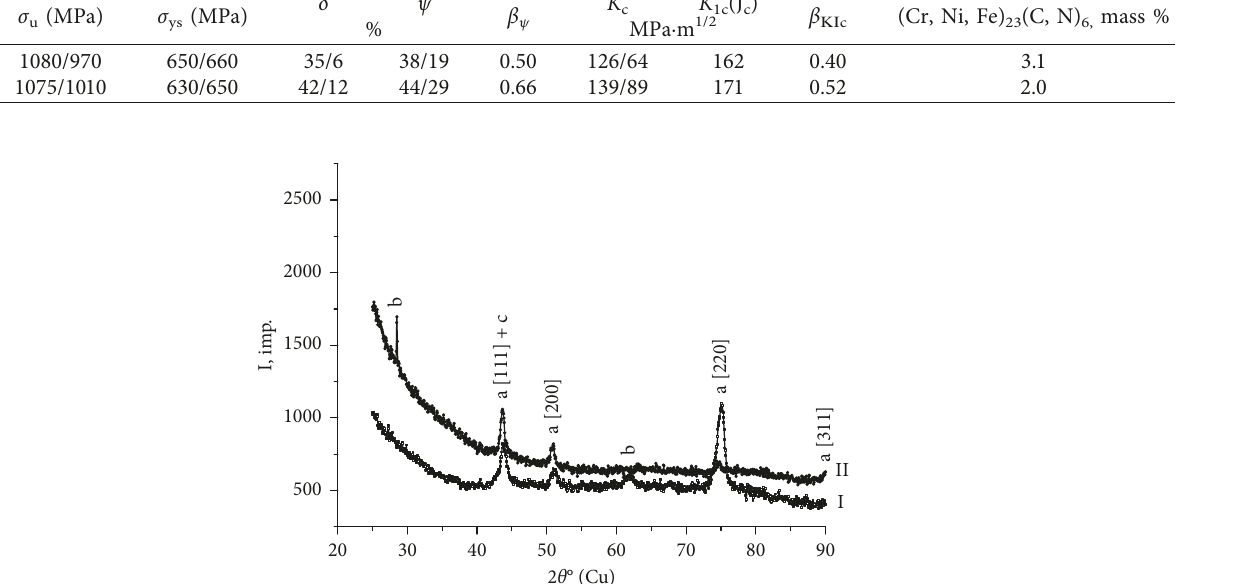
Figure 7: X-ray patterns of the alloys with different content of carbides (I, II, see Table 1): a, Ni-base solid solution; b, Ni c, (Cr, Ni, Fe) 23 (C, N) 6 .